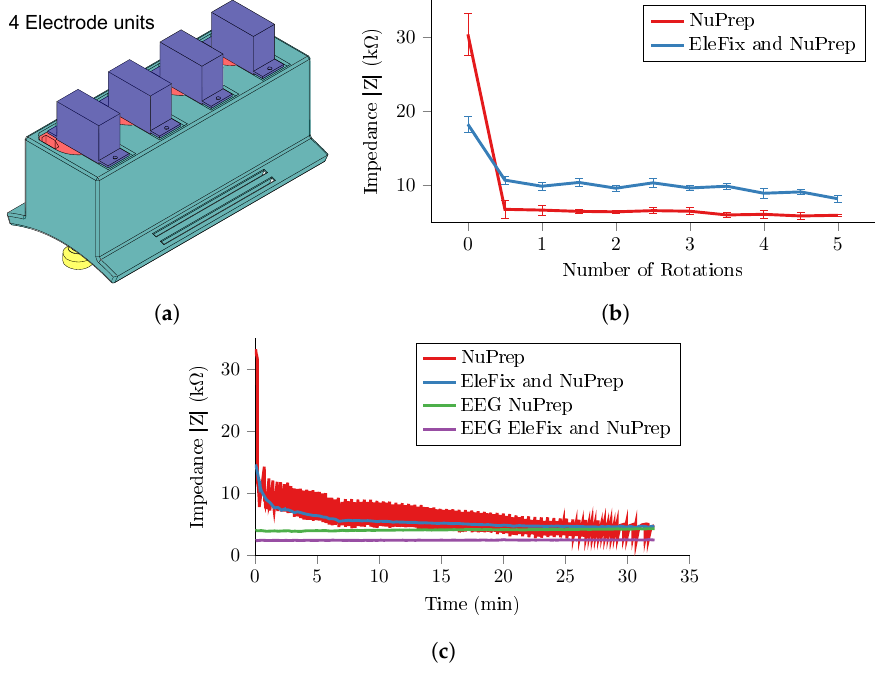
Figure 12. Linear array of four units ( a ) electrode housing ( b ) abrasion with application of abrasive Nuprep paste and with EleFix EEG gel and Nuprep paste ( c ) long term recording with two actuated electrodes and two conventional EEG